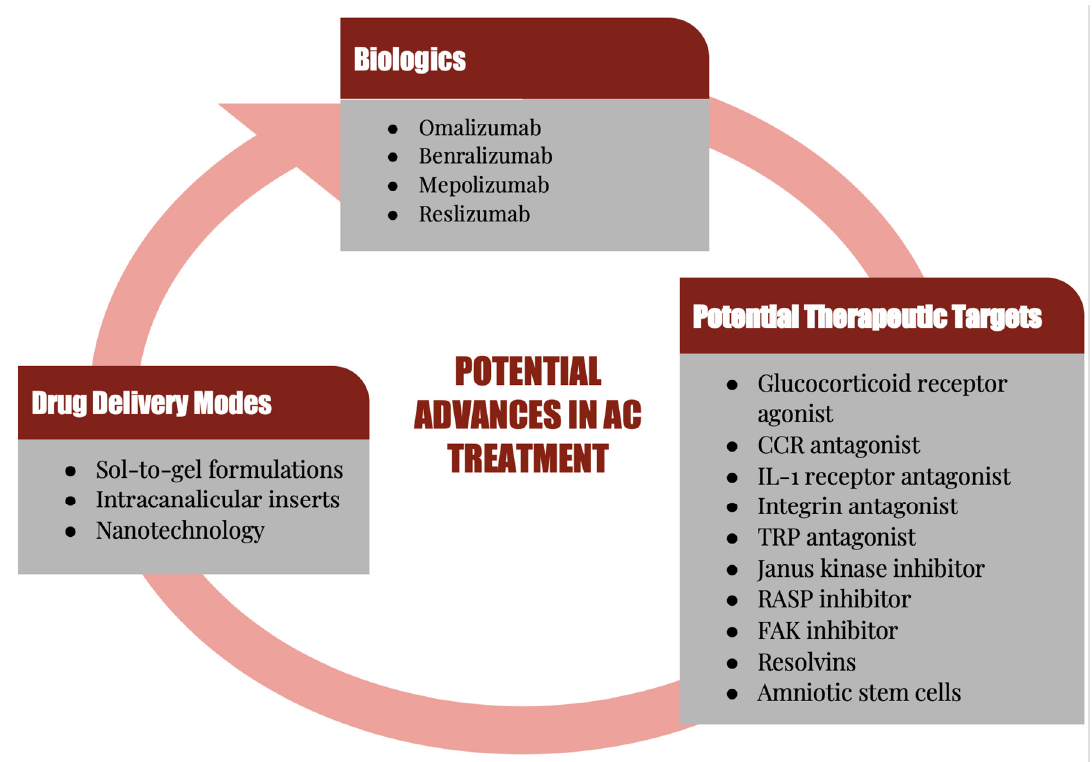
Figure 1. Summary of potential future therapeutic targets for allergic conjunctivitis. AC: allergic conjunctivitis; CCR antagonist: C-C chemokine receptor antagonist; L-1 receptor antagonist: Interleukin-1 receptor antagonist; TRP antagonist: Transient receptor membrane potential antagonist; RASP inhibitor: Reactive aldehyde species (RASP) inhibitor; FAK inhibitor: Focal adhesion kinase (FAK) inhibitor.